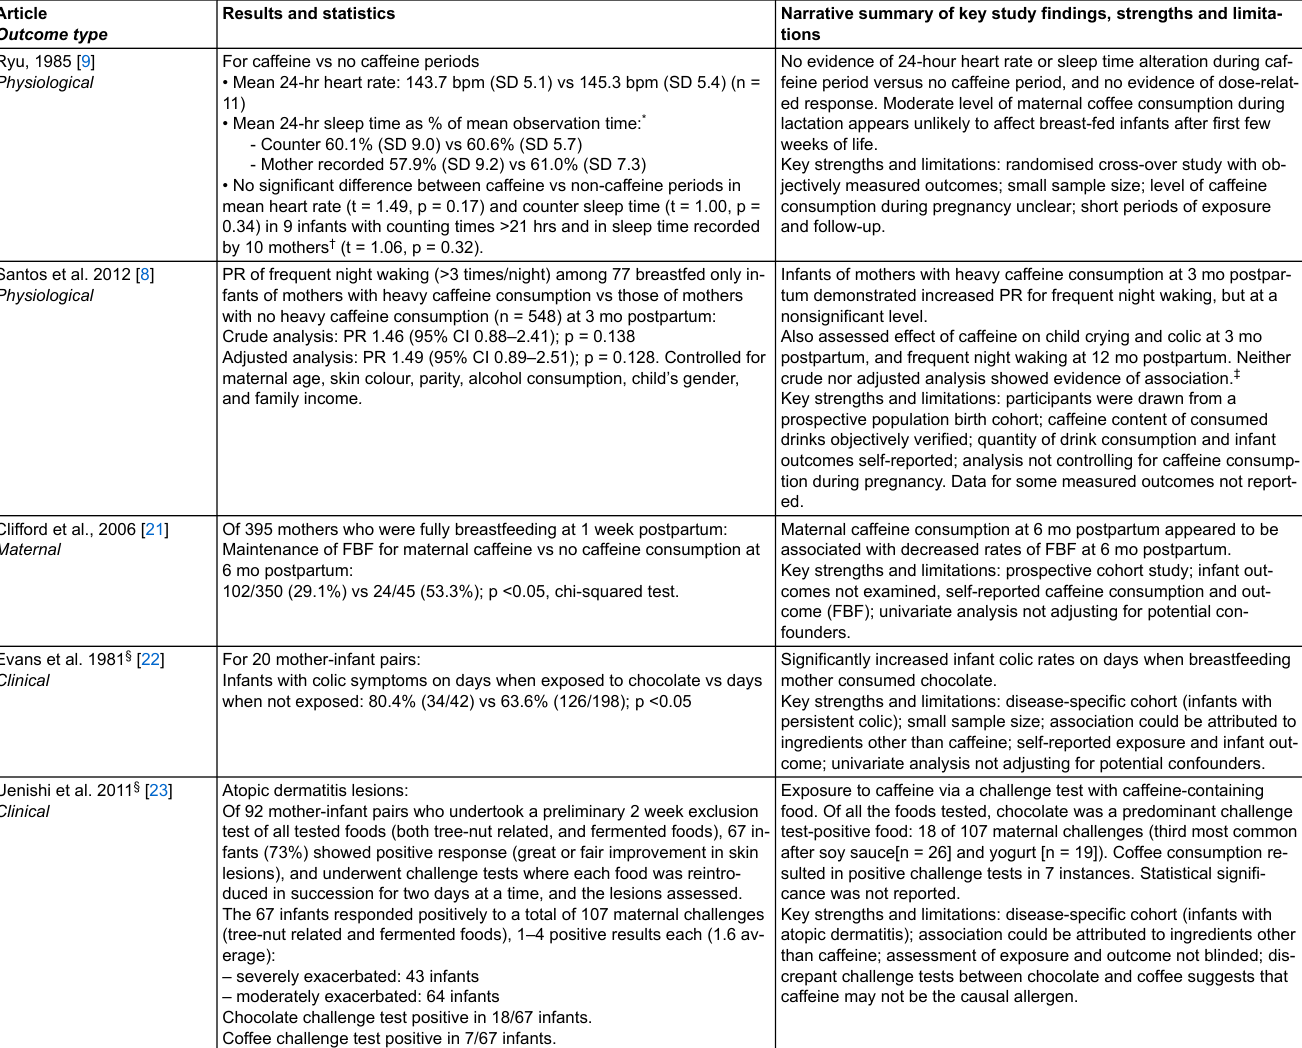
Table 3: Summary of results from included